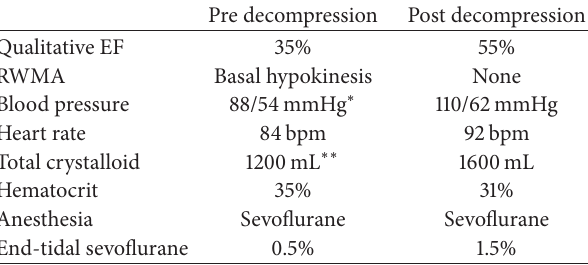
Figure 1: Right holohemispheric subdural hematoma (SDH) and midline shift in a 76-year-old male, resulting in neurologic deteri- oration and emergent surgical decompression management. Table 1: Changes in qualitative ejection fraction (EF) and regional wall motion abnormalities (RWMA) pre and post decompressive craniotomy in a patient with isolated traumatic brain